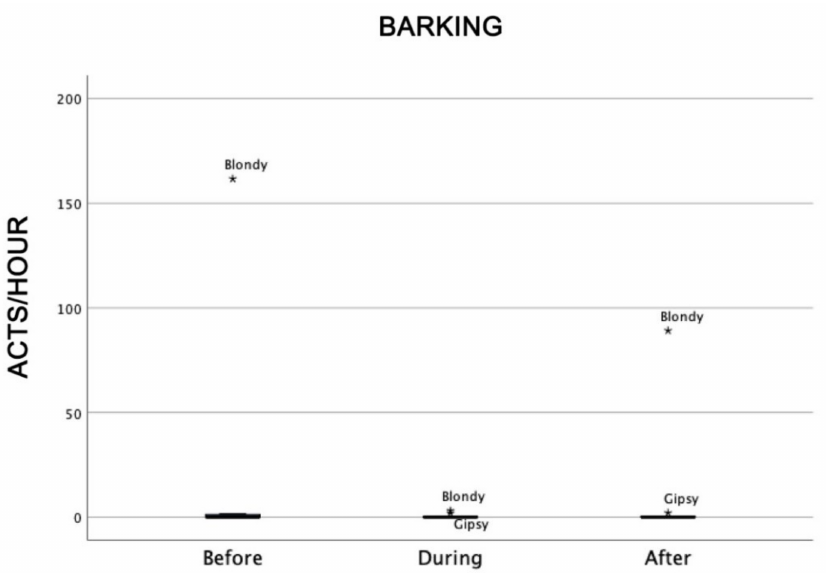
Figure 12. Barking of dogs before, during, and after AAI sessions. Non-parametric data are represented as medians (horizontal bar in the box) and the box indicates the interquartile range of 50% of the data. Whiskers extend to the smallest and largest values and exclude outliers (dot on